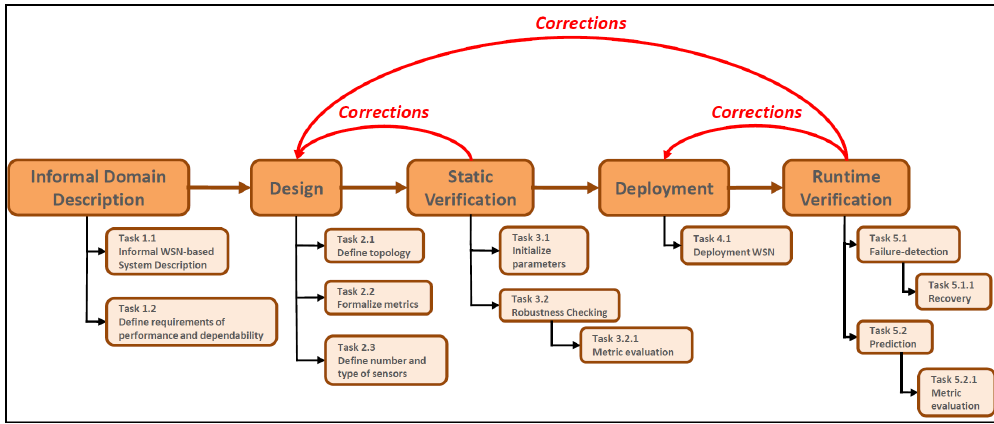
Figure 1. The process of the proposed